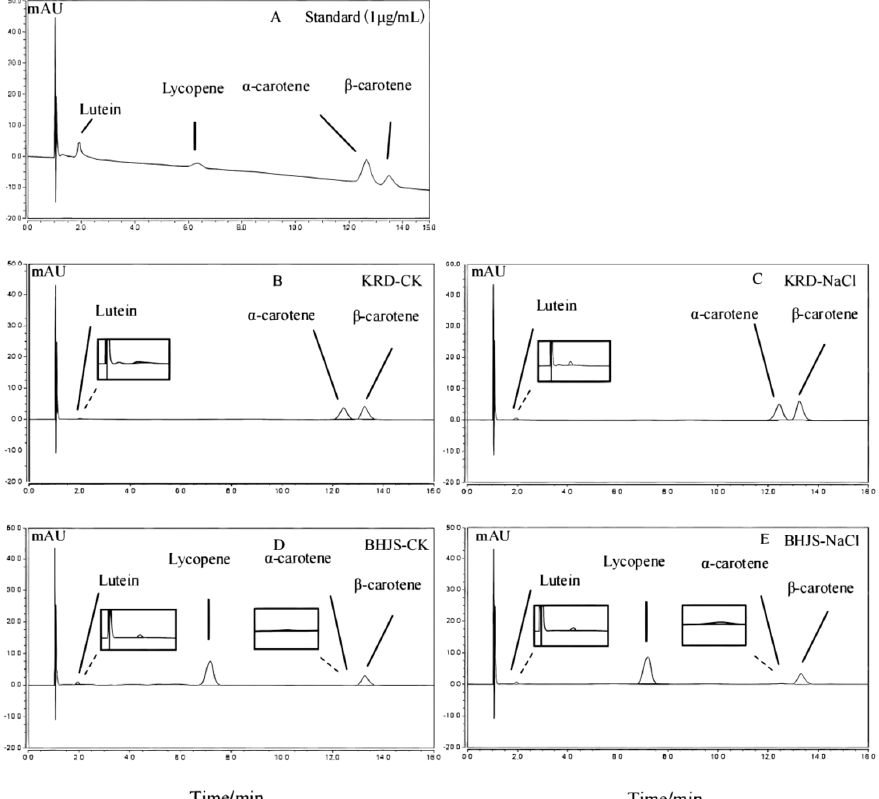
Figure 3. UPLC chromatograms of carotenoids in different carrot cultivars and treatments. ( A ) Standard UPLC chromatograms of carotenoids; ( B ) UPLC chromatograms of carotenoids in ‘KRD’ of control group; ( C ) UPLC chromatograms of carotenoids in ‘KRD’ of salt treatment group; ( D ) UPLC chromatograms of carotenoids in ‘BHJS’ of control group; ( E ) UPLC chromatograms of carotenoids in ‘BHJS’ of salt treatment group. Cultivar abbreviations: BHJS, Benhongjinshi; KRD, Kurodagosun.